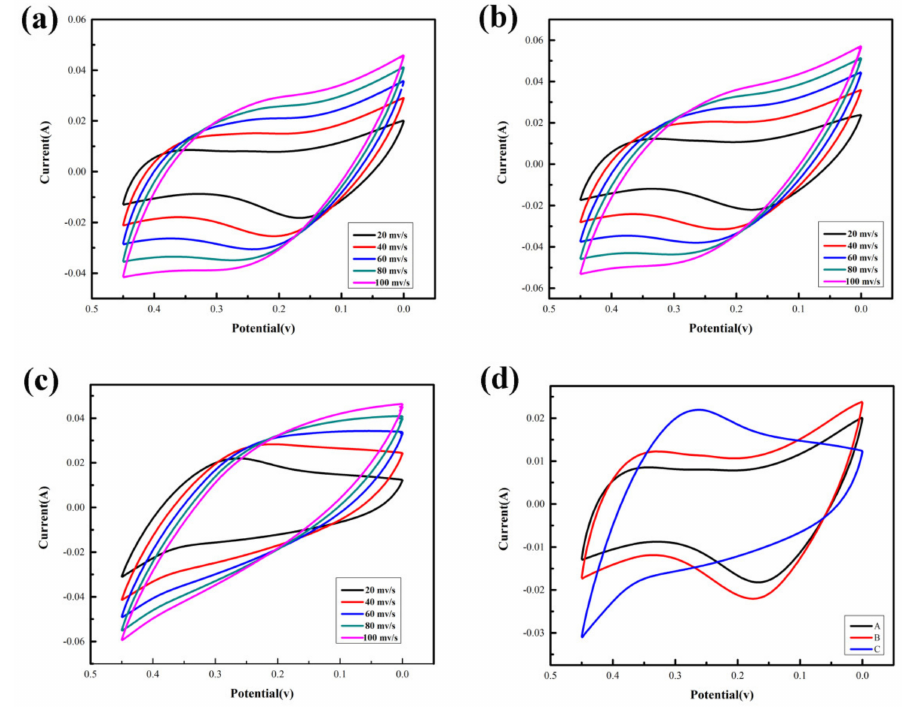
Figure 6. CV curves of the di ff erent Co 3 O 4 electrodes: ( a ) A, ( b ) B, ( c ) C and ( d ) CV curves of the di ff erent Co 3 O 4 electrodes at 20 mV · s − 1